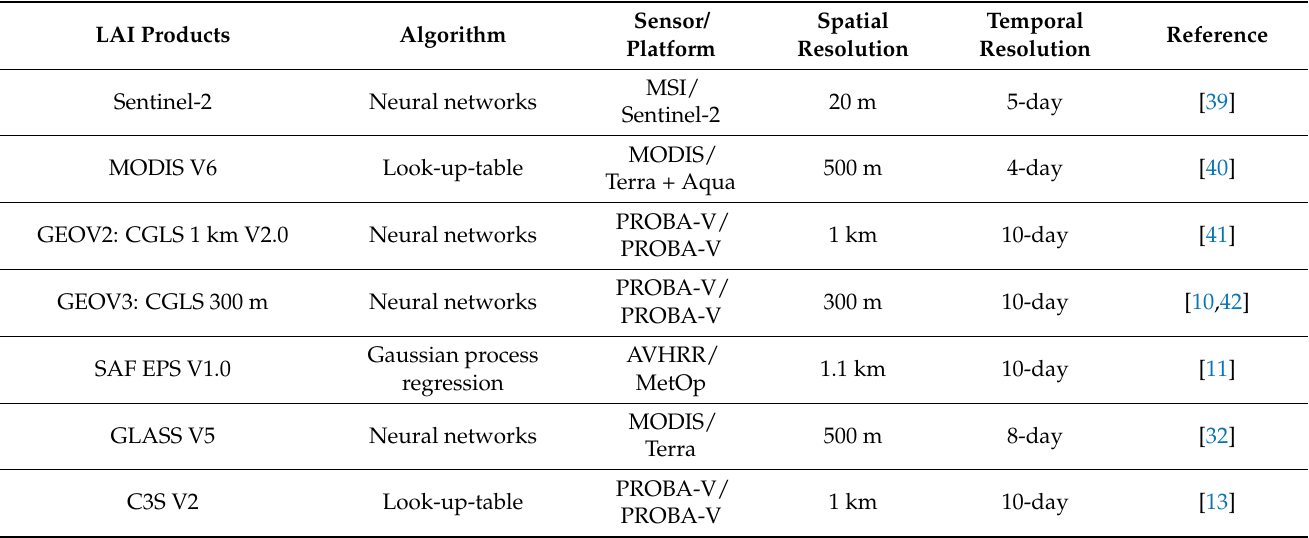
Table 1. Multi-resolution LAI products investigated in the